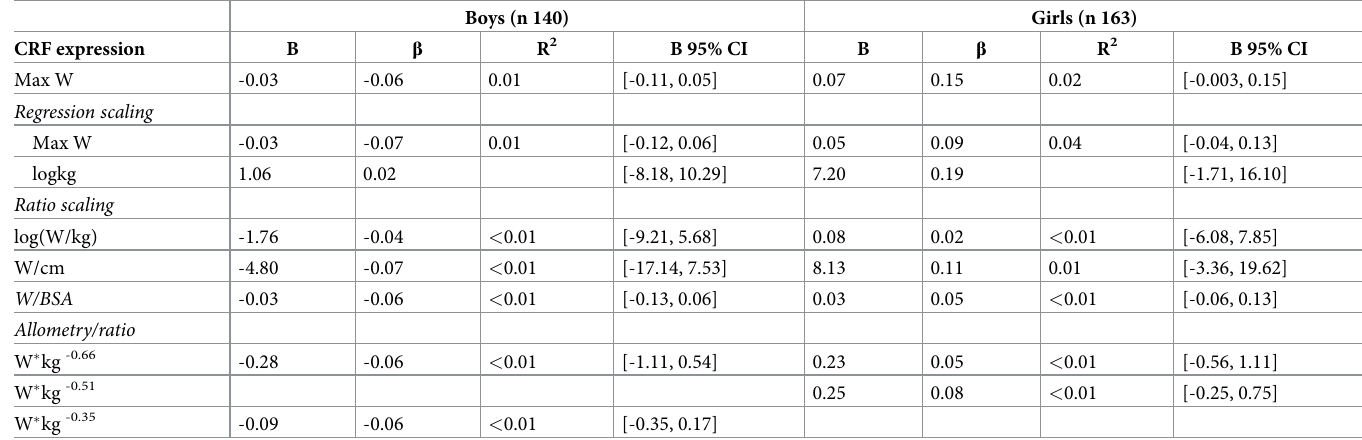
Table 3. Regression coefficients between academic achievement and different CRF